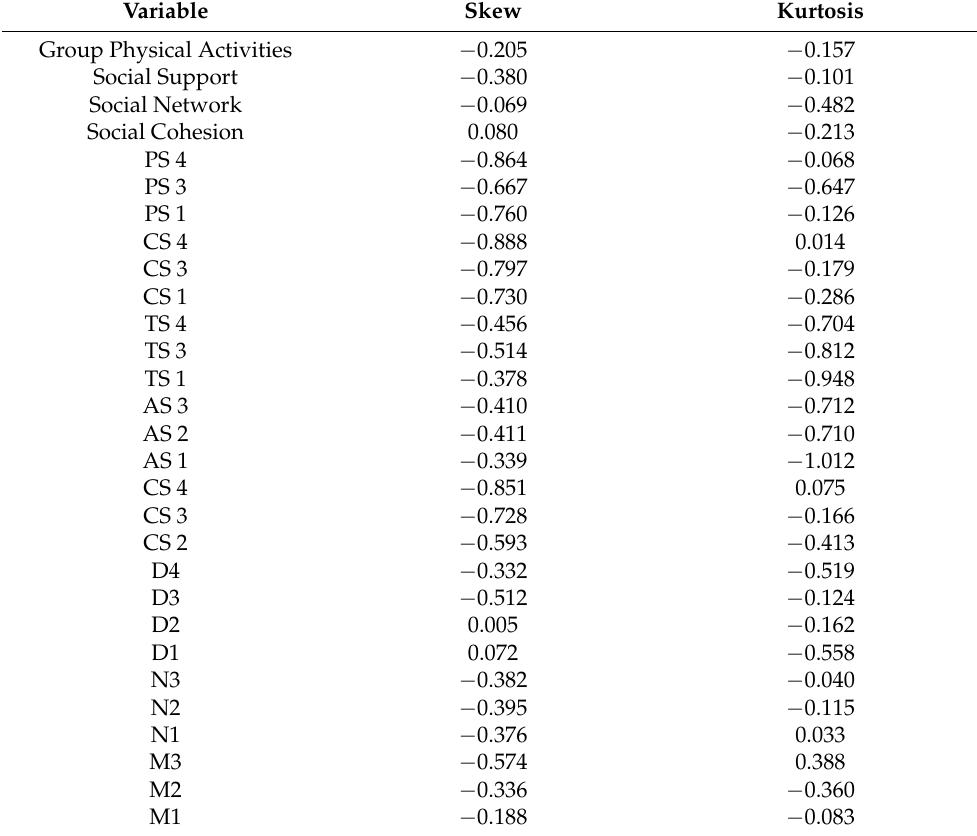
Table A1. Assessment of